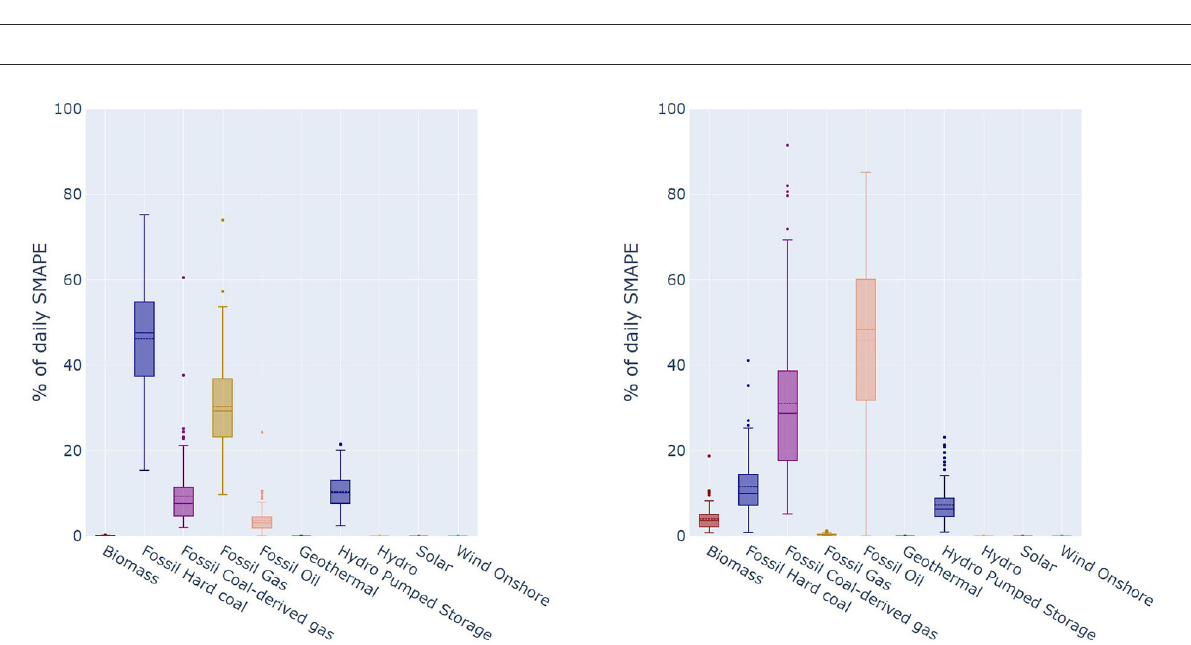
FIGURE5 Box plots of the SMAPE for the Climate change total (left) and Respiratory effects, inorganics (right) LCA impact indicators. DF approach is shown in red, while ETMF in blue. The continuous line at the center of each boxplot is the median of the distribution, while the dotted line is the mean.